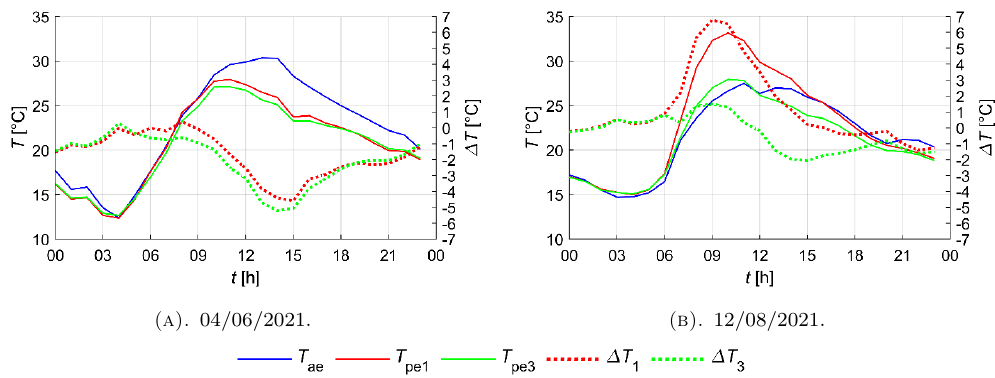
Figure 5. Surface temperature of plants T days.